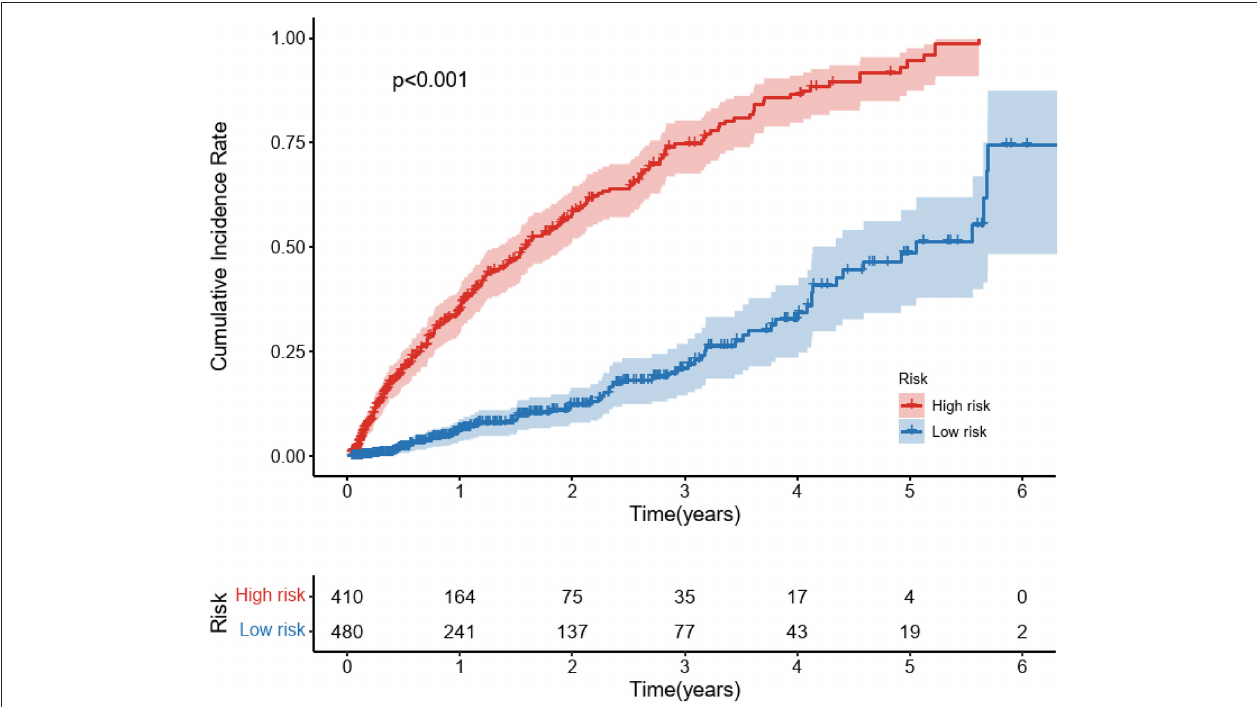
FIGURE 5 | Cumulative Incidence curves for predicted cardiovascular disease among diabetic kidney disease patients in different risk groups. Cardiovascular disease is the composite of coronary heart disease, cerebrovascular disease, congestive heart failure, and peripheral arterial disease. Patients were stratified into a high-risk group and a low-risk group based on the cut-off value of the ROC curve. The P -values between the high-risk and low-risk subgroups were calculated by the log-rank test.